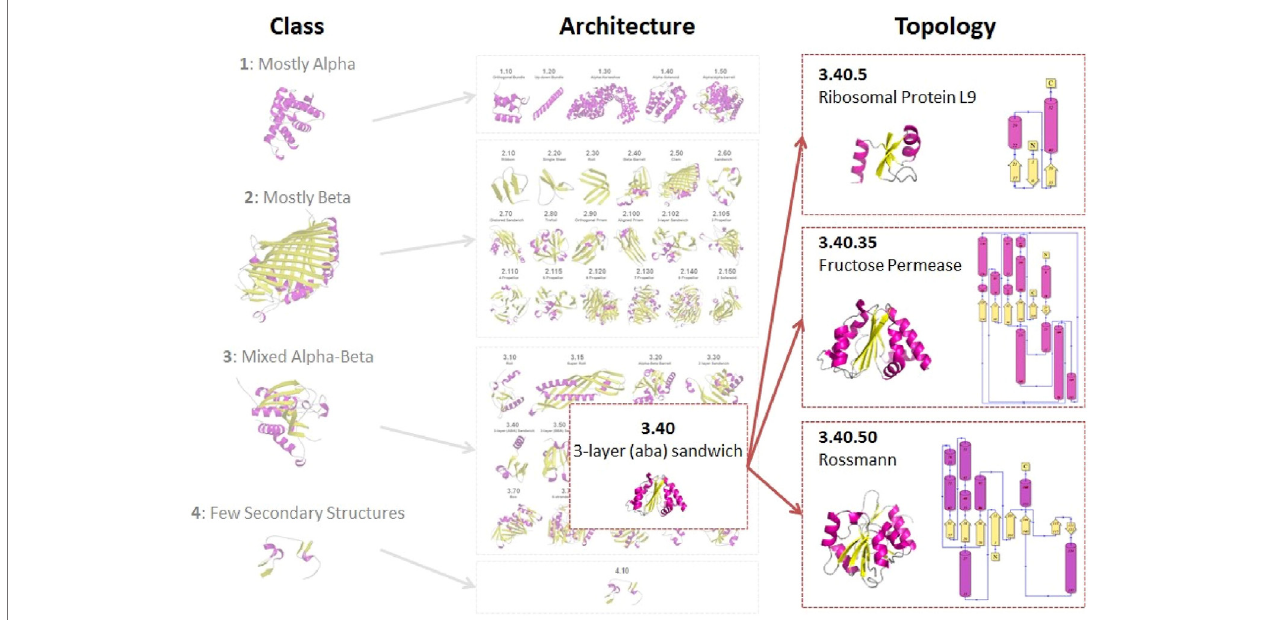
FIGURE 3 | Overview of the CATH classi fi cation scheme for protein domains.